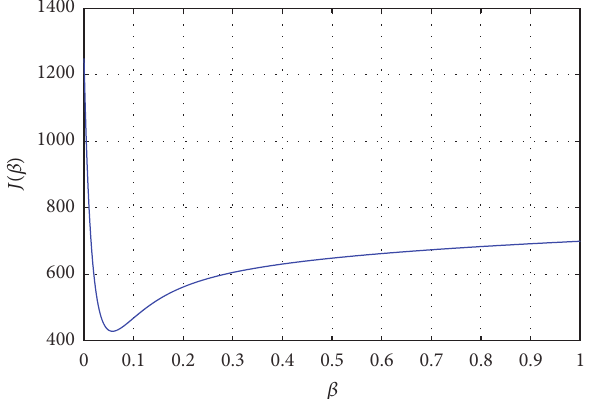
Figure 1: Schematic illustration of the function 𝐽(𝛽) .